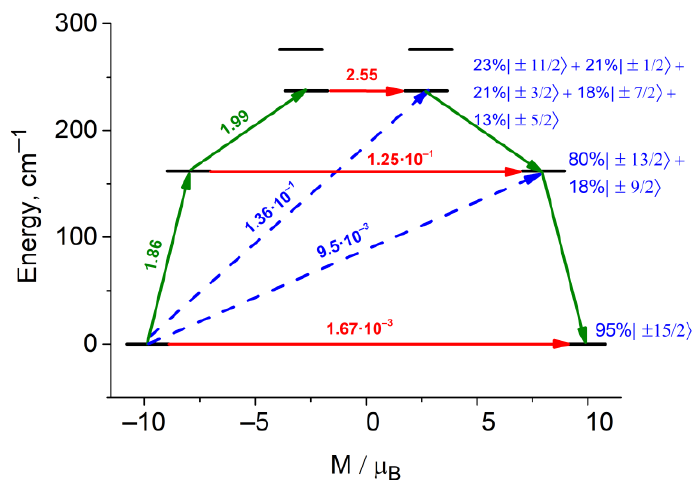
Figure 6. The computed possible magnetization relaxation pathways for one Dy ion in 1 . The red arrows show QTM and TA-QTM via ground and higher excited KD, respectively. The blue arrows show the Orbach process for relaxation. The green arrows show the mechanism of magnetic relaxation.